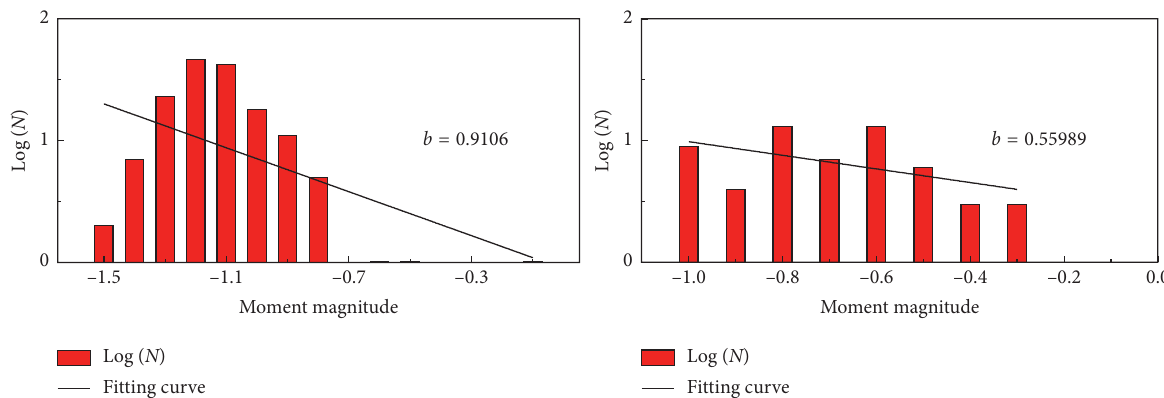
Figure 5: Moment magnitude-frequency distribution of microseismic events at different advancing speeds. (a) Slow advancing stage. (b) Fast advancing stage.